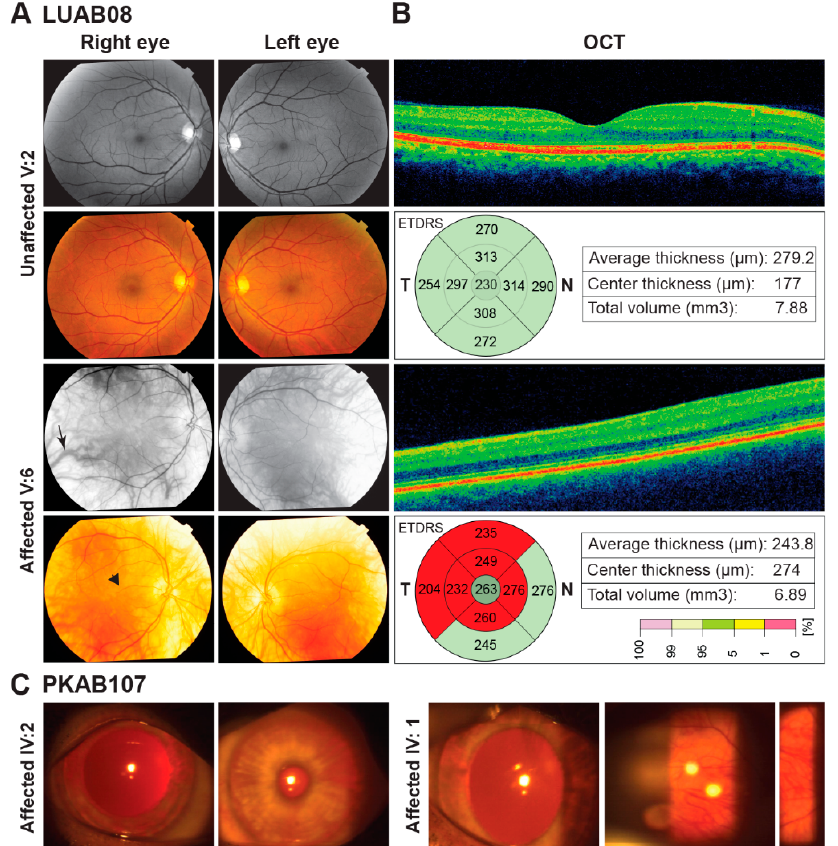
Figure 3. Fundus photographs and optical coherence tomography (OCT) images of OCA affected individuals. A. Fundus photographs of normal (V:2) and affected (V:6) individual of family LUAB08. Affected (V:6) represents albinotic fundus, prominent choroidal vasculature (arrow), foveal hypoplasia (arrowhead), and thin retinal thickness. B. OCT images of normal (V:2) and affected (V:6) individual of family LUAB08. C. Slit lamp microscopy in the affected individuals (IV:1 and IV:2) of family PKAB107 represent iris transillumination and albinotic